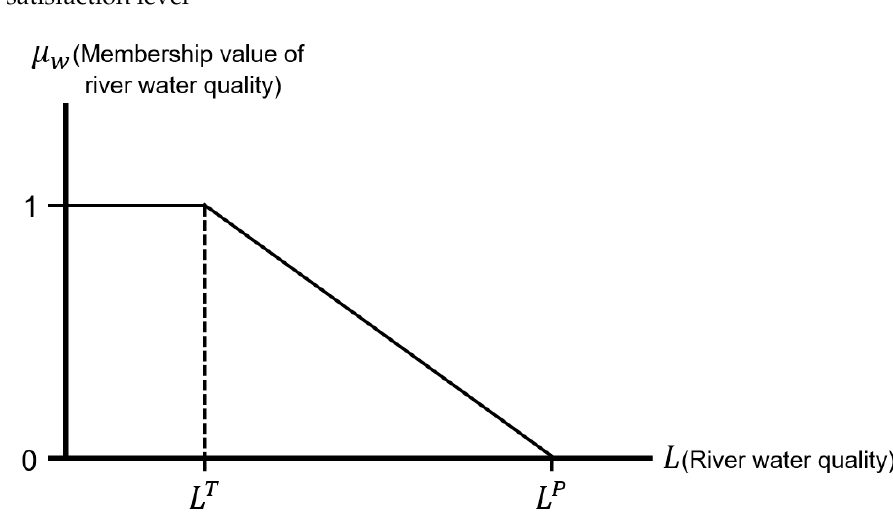
Figure 3. Membership function of river water quality (BOD).